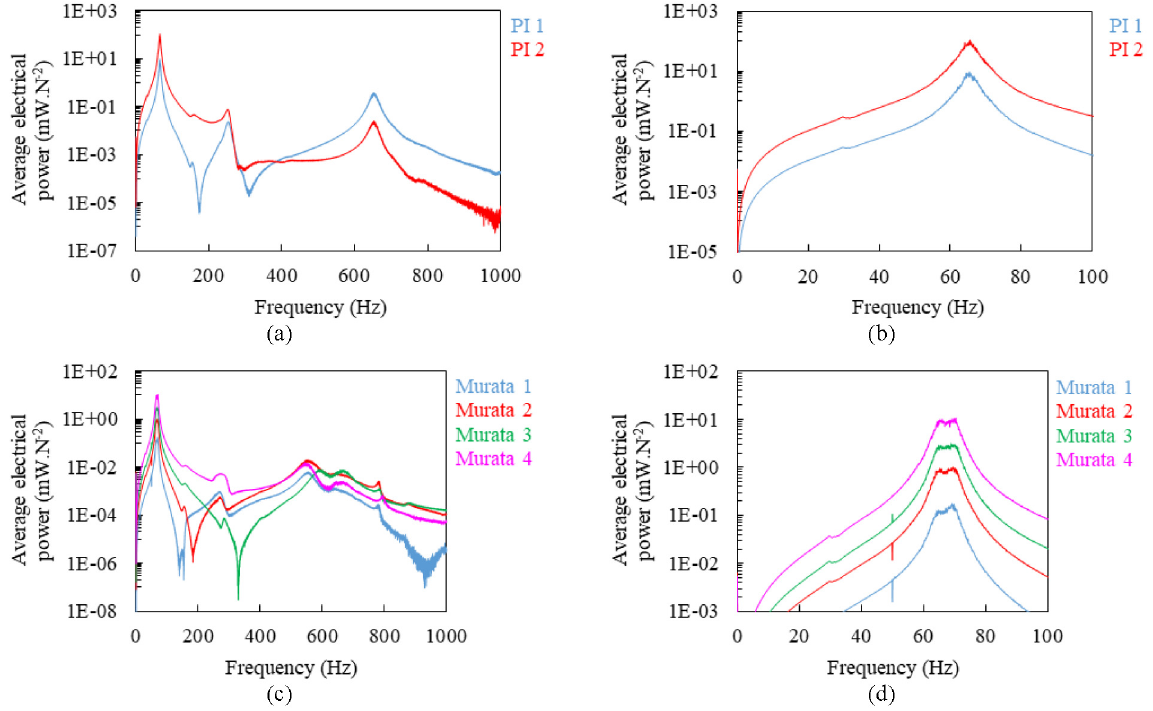
Fig. 14. (a) and (c) Transfer function of the different piezoelectric structures by injecting a white noise at the free end of the arm (the other end is clamped). Integrated structures: R =200 k V , Murata buzzers: R =100 k V , PI DuraAct patches: R =70 k V . (b) and (d) Zoom on the fi rst